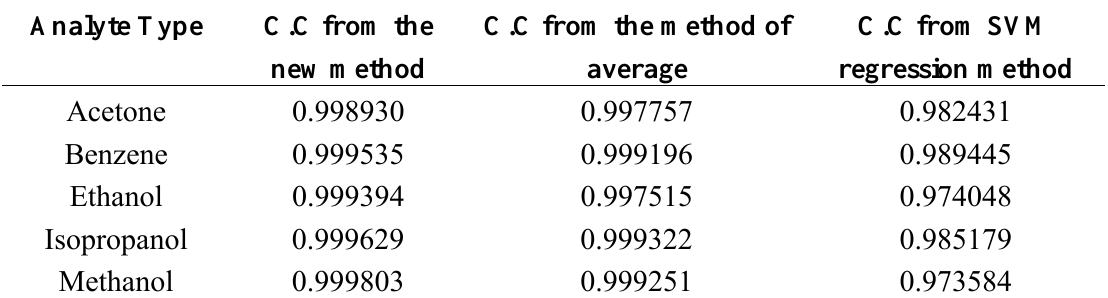
Table 9. Correlation Coefficient (C.C) value for each